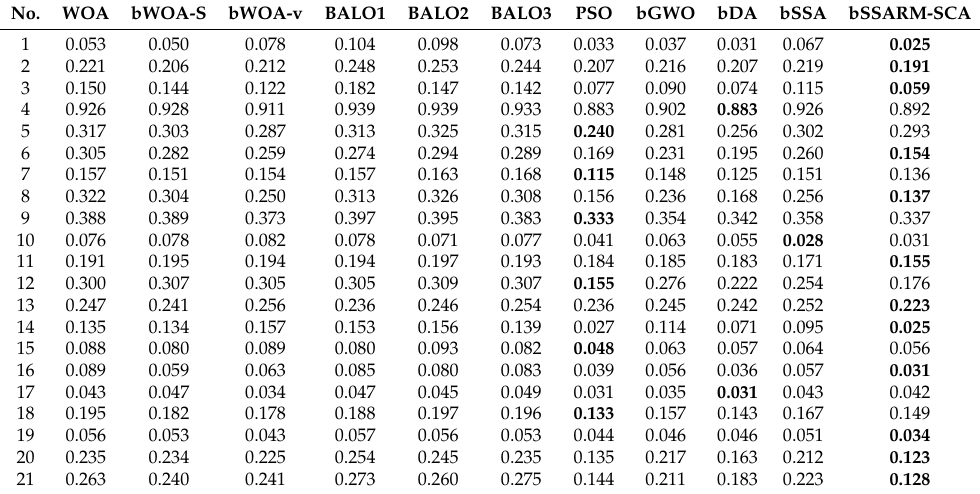
Table 14. Mean fitness statistical metric using mixed initialization with the 21 utilized datasets.